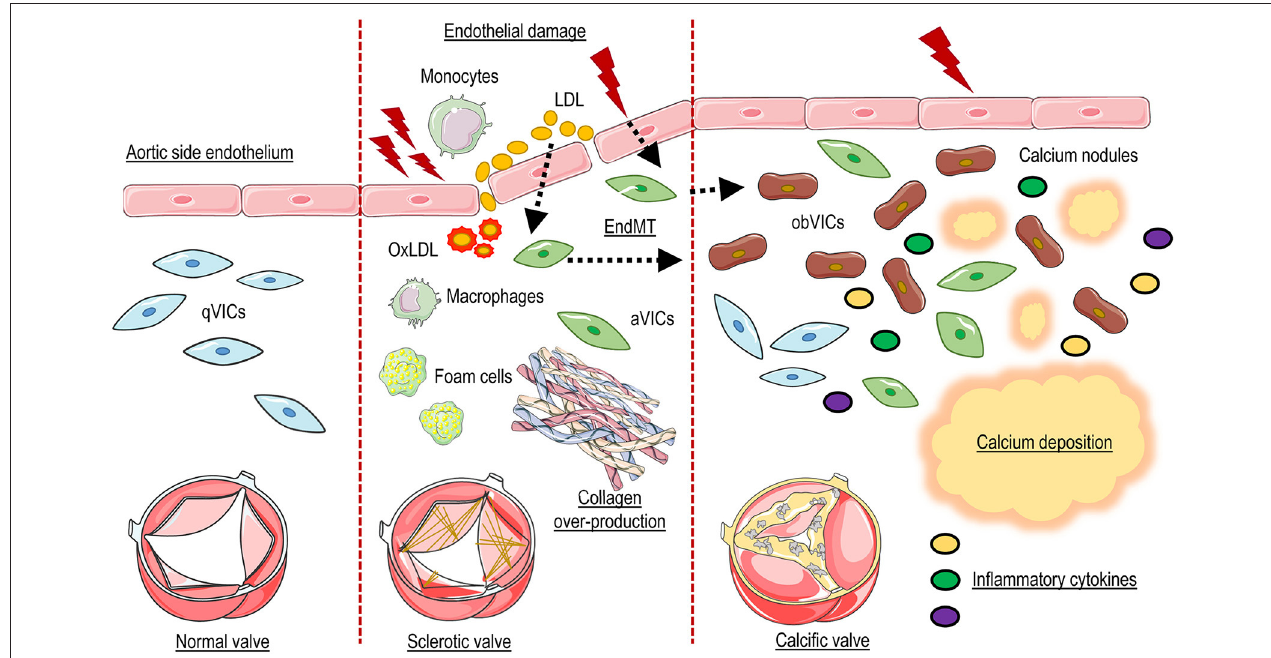
FIGURE 1 | Schematic representation of CAVD pathophysiology. Endothelial damage allows penetration and accumulation of lipids and inflammatory cells into the valve tissues, and End-MT. Oxidative modification of lipoproteins (OxLDL), formation of foam cells, and the production of inflammatory cytokines promotes the activation of resident valve interstitial cells (aVICs) which, in combination with invading inflammatory cells and oxidized lipids, promote fibrosis and thickening of the valve interstitial tissue. In the last phase of the pathology aVICs give rise to calcific cells (obVICs) responsible for secretion of mineralized microparticles and formation of calcium nodules.